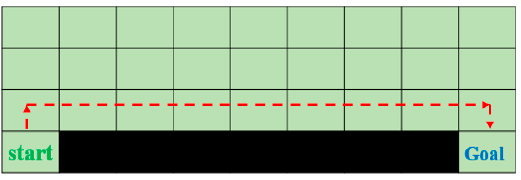
Figure 17. The Q-learning algorithm route.